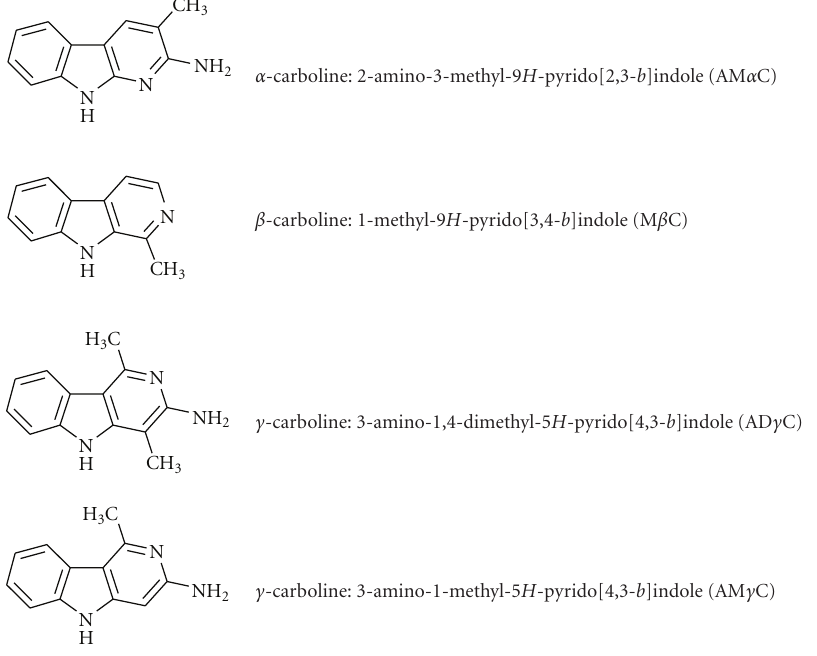
Figure 1: The structures of α -, β -, and γ -carbolines tested in this